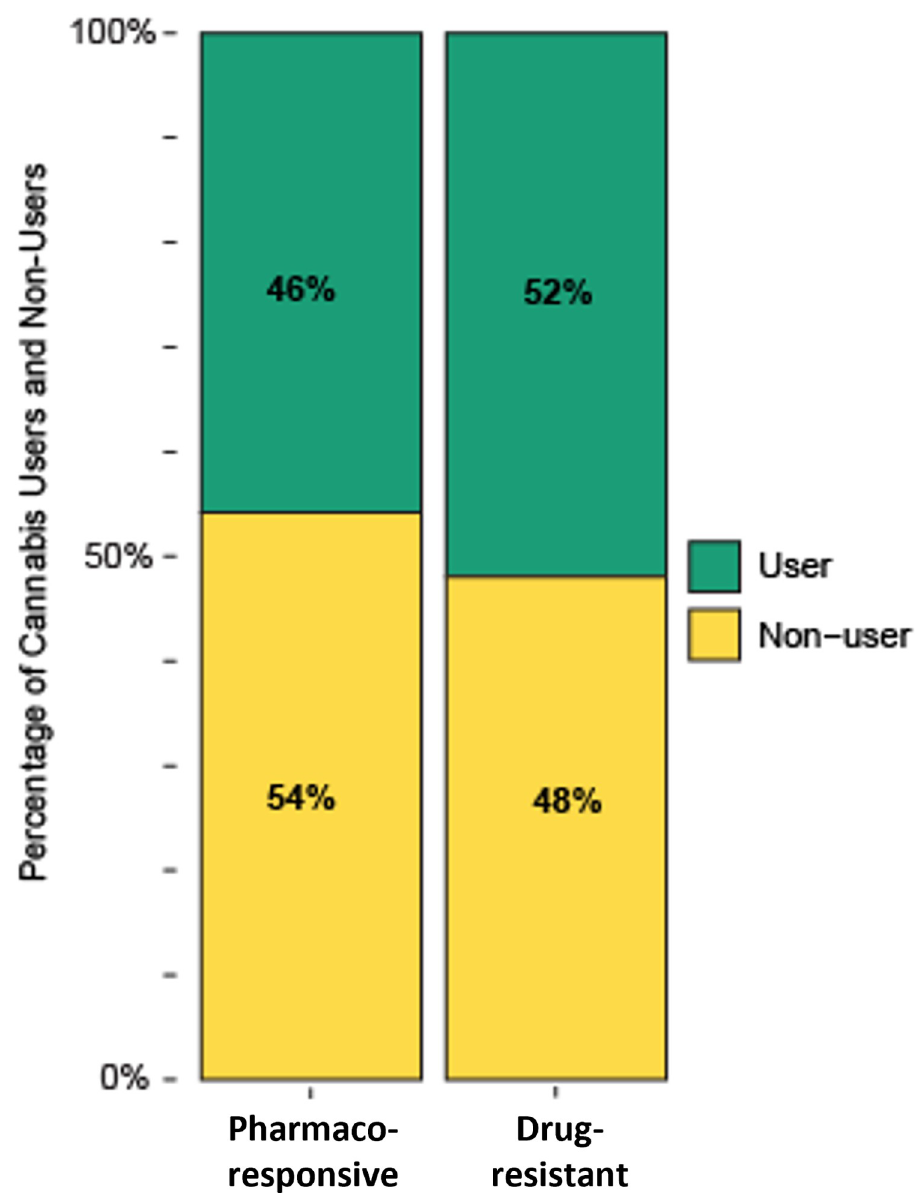
Fig 1. Proportion of cannabis users in study sample. Results of Fisher’s exact test and relative distributions of cannabis use in participants with drug-resistant and pharmacoresponsive epilepsy.